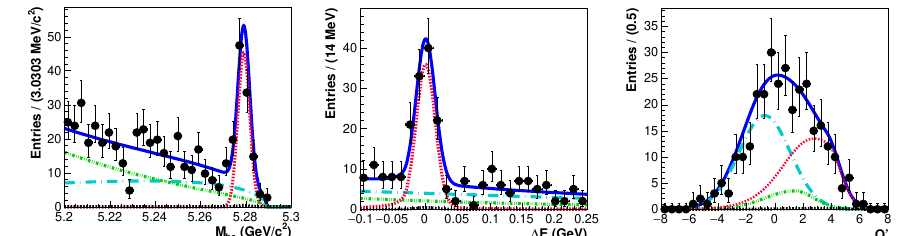
Figure 6. Signal-enhanced M bc (left), ∆ E (middle), and O 0 (right) projections for B + → K + µµ decay. Point with error bars are the data, blue solid curves are the fitted result, red dashed curves denote the signal component, cyan long dashed, green dash-dotted, and black dashed curves represent continuum, B ¯ B background, and B → charmless decays, respectively.